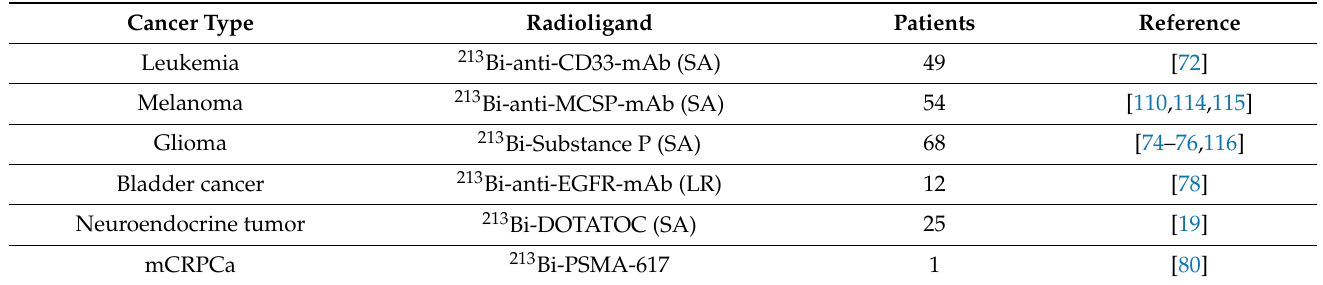
Table 4. Overview of Clinical Studies with 213 Bi-labeled